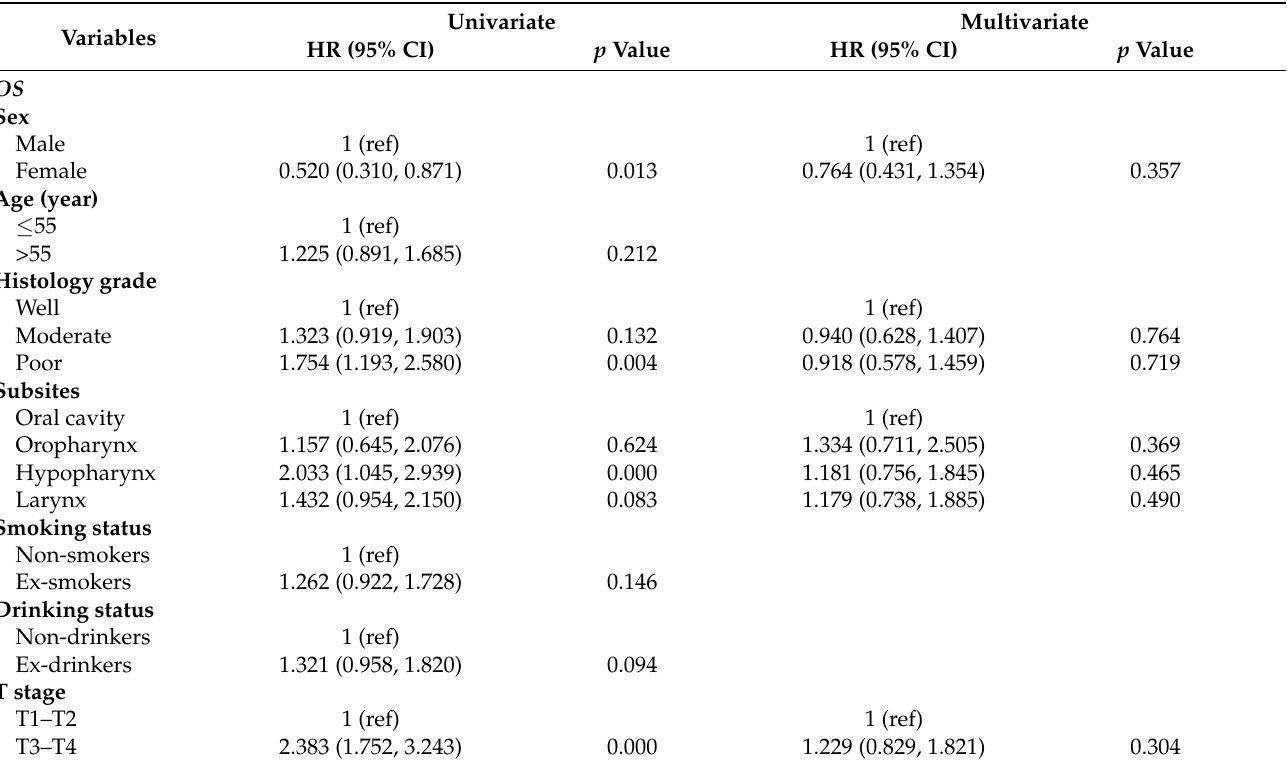
Figure 3. Association between subsites ( A ), histological grade ( B ), recurrence/metastasis ( C ) or death event ( D ) and FOXD1 expression. Table 2. Univariate and multivariate analysis on overall survival and disease-free survival by Cox regression